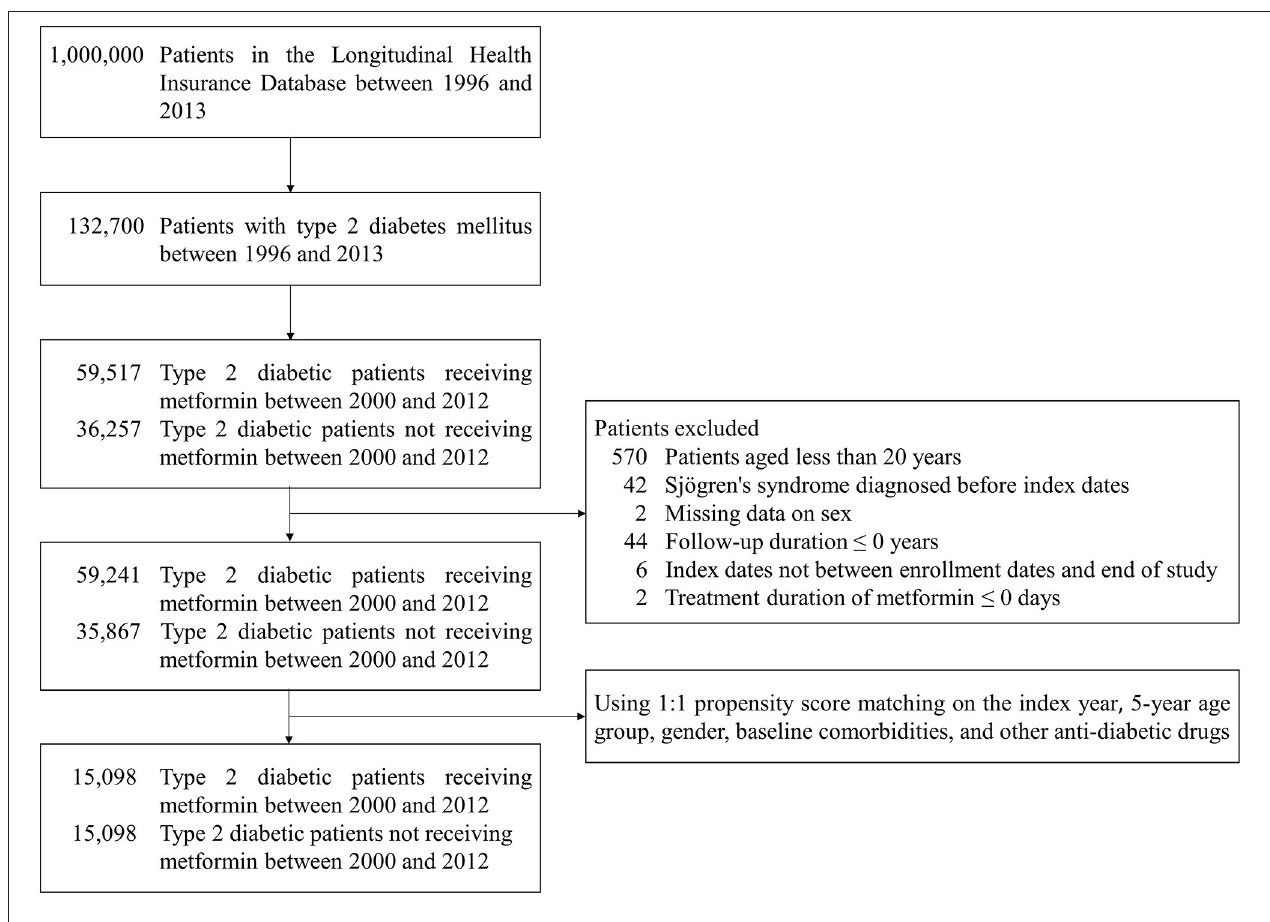
FIGURE 1 | Flowchart of the study population selection.